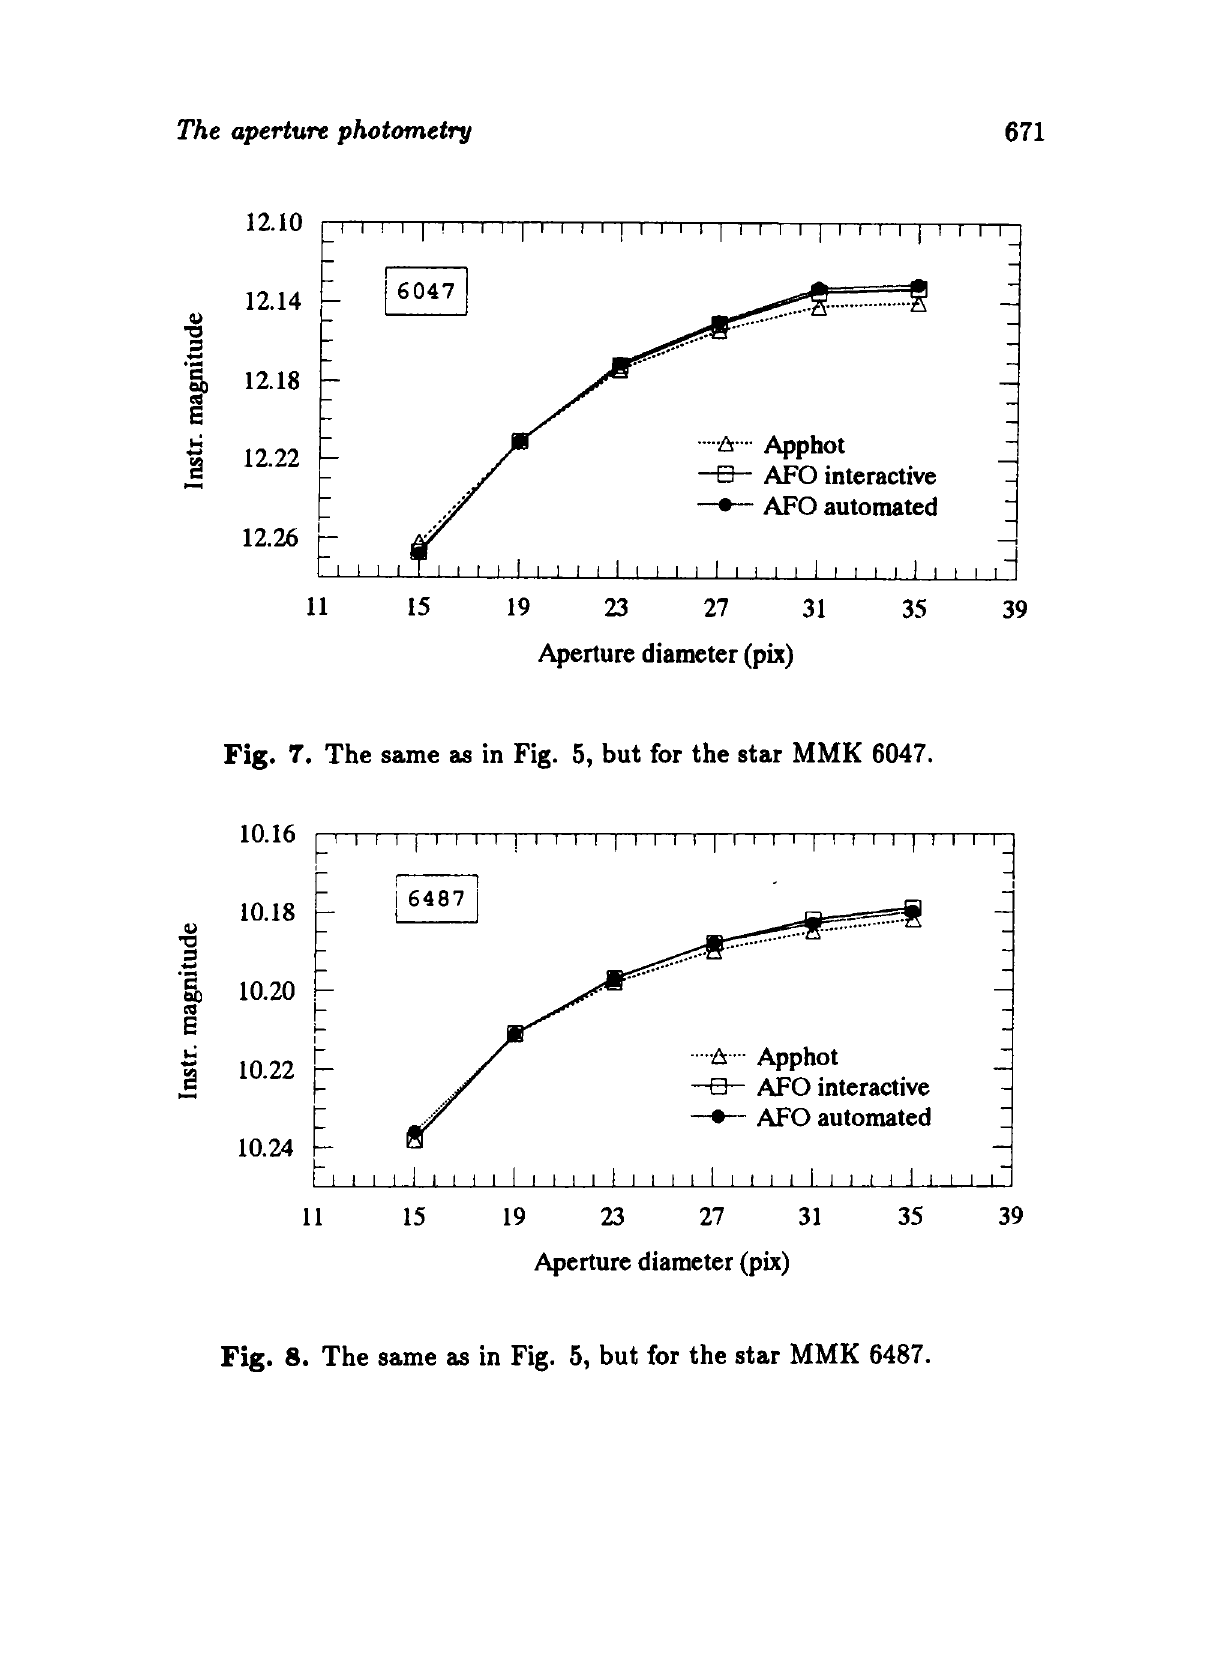
Fig. 8. The same as in Fig. 5, but for the star MMK